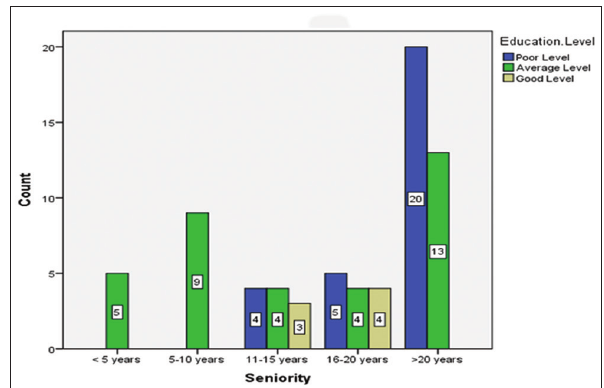
Figure-2: Number of respondents by years of